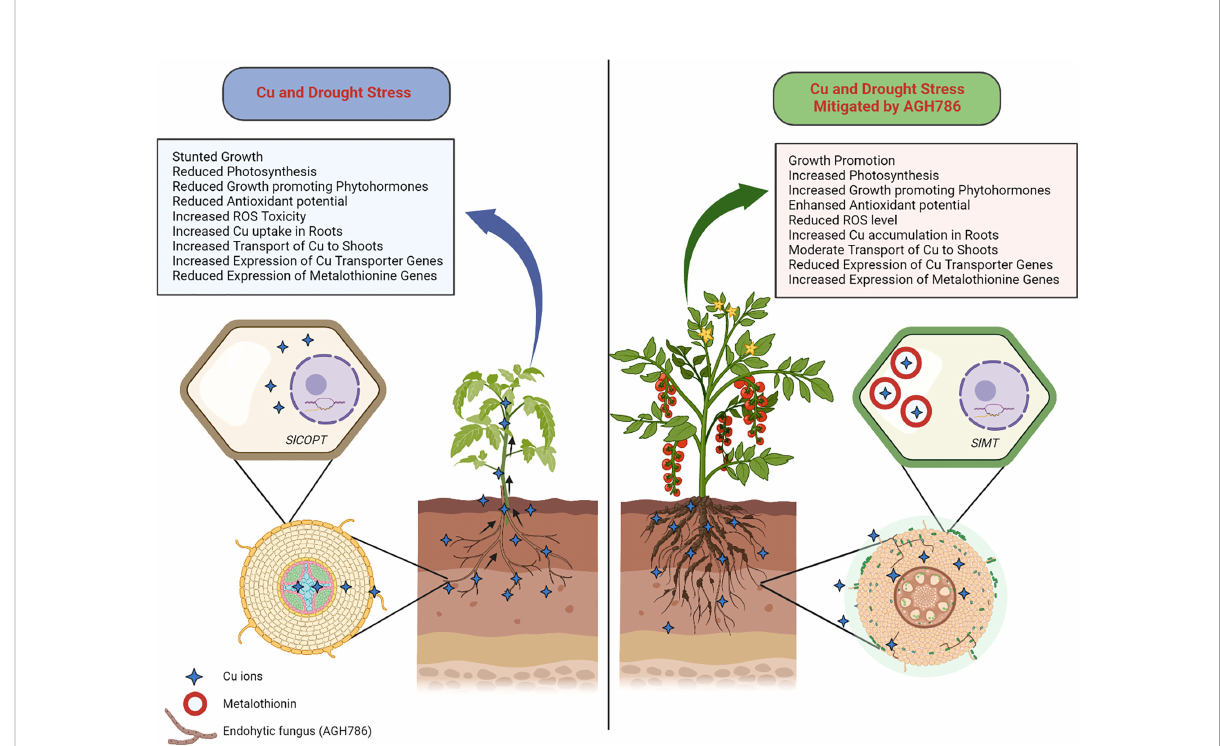
FIGURE 10 Role of P. spadiceum AGH786 under combined stress of Cu and drought in S. lycopersicum L. Cu and drought stress inhibited plant growth, while the association of AGH786 ameliorated S lycopersicum L. growth under Cu and drought stresses, through secreting phytohormones and essential secondary metabolites under stress conditions and modulating the plant gene expression of Cu transporters, metal chelators, and stress-related biomarker genes such as the SlCOPT and SlMT genes in the S. lycopersicum L. for restricting and sequestering the heavy metal ions in the root